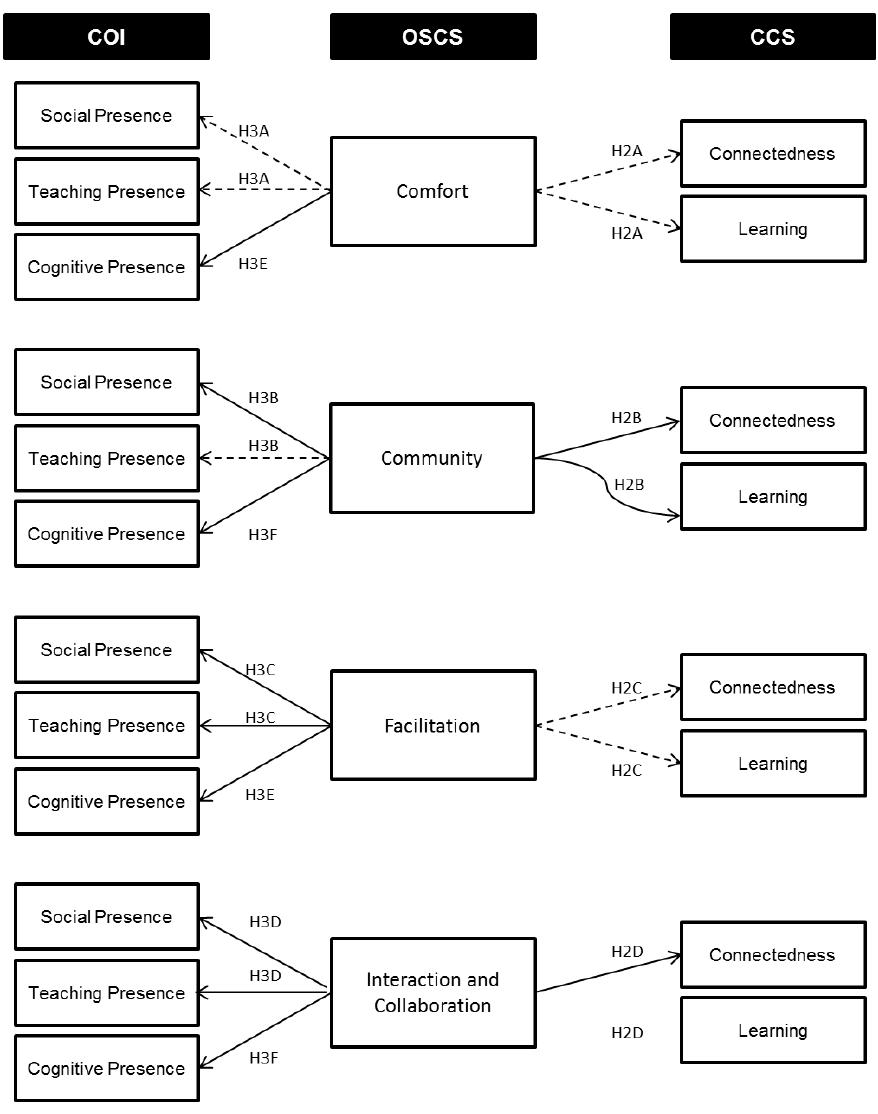
Figure 3. Final model for OSCS nomological